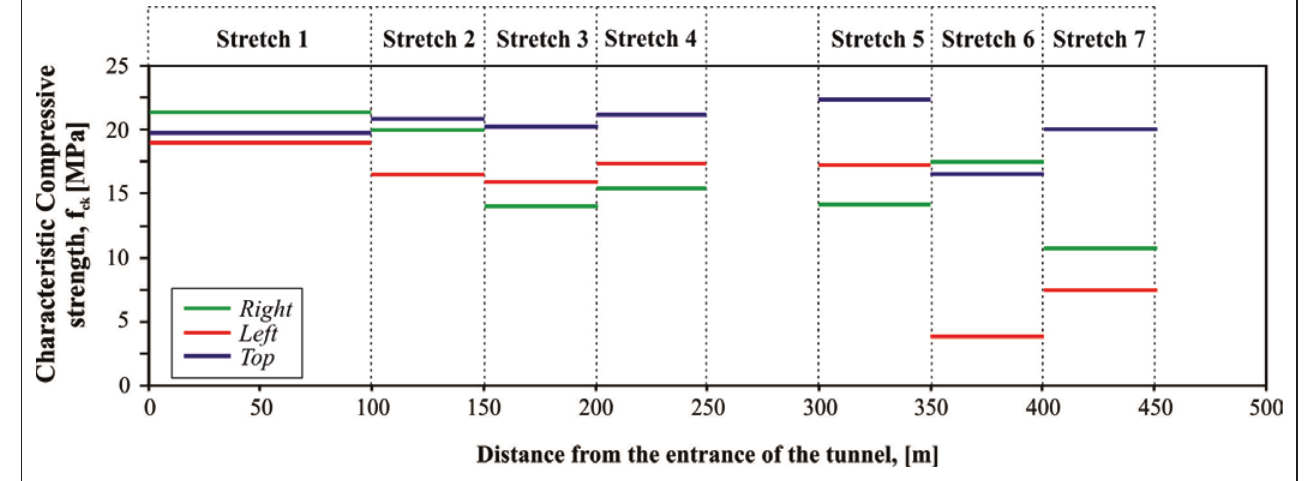
Figure 10 – Characteristic compressive strength of the concrete lining in different sections of the tunnel